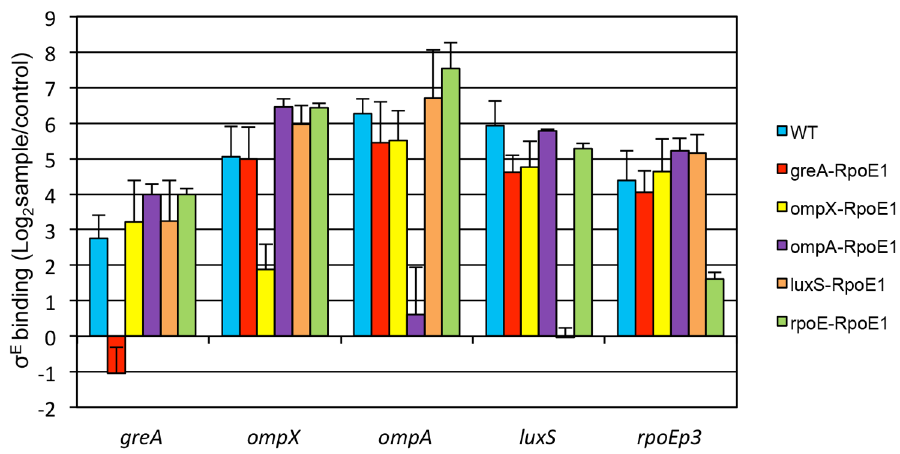
Fig 5. Scrambled σ E consensus sequence decreases/eliminates σ E binding. The substitutive consensus sequence consisted of nucleotides with the least prevalence at the corresponding positions in the consensus sequence. The σ E consensus sequences upstream greA , ompX , ompA , luxS , and rpoE genes were replaced by the substitutive sequence (RpoE1), and the resulting mutants were named greA -RpoE1, ompX -RpoE1, ompA -RpoE1, luxS -RpoE1, and rpoE -RpoE1 respectively. These mutants and WT bacteria were grown in LPM for 4 h, crosslinked, sonicated, and immunoprecipitated with anti- σ E Ab (sample) or anti- GFP Ab (control). qPCR was used to determine the binding of σ E at each original site. The mean and S.D. values were obtained from independent biological